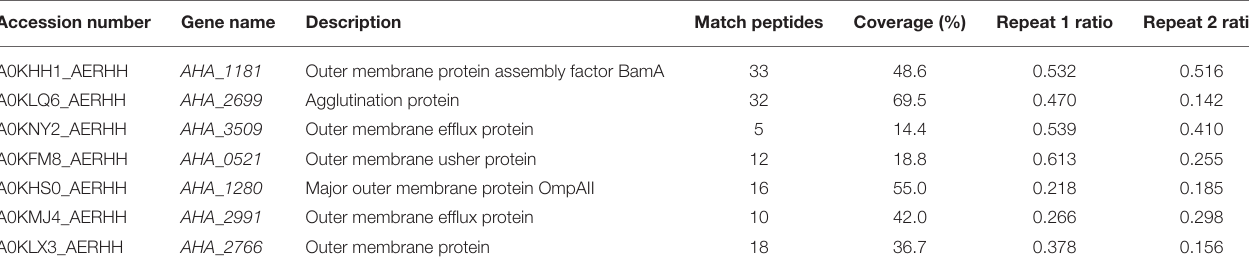
TABLE 1 | Significantly differentially expressed OMPs in A. hydrophila ATCC 7966 OXY-resistant strain by LC